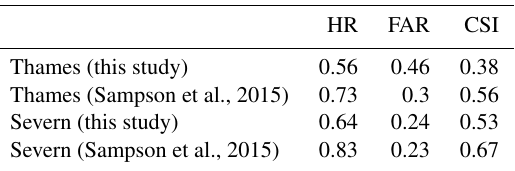
Table 7. Comparison of the performance metrics for the maps de- scribed in the present study and the global maps by Sampson et al. (2015). Metrics for the latter study are calculated removing all channels with upstream areas of less than 500km 2 . HR FAR CSI